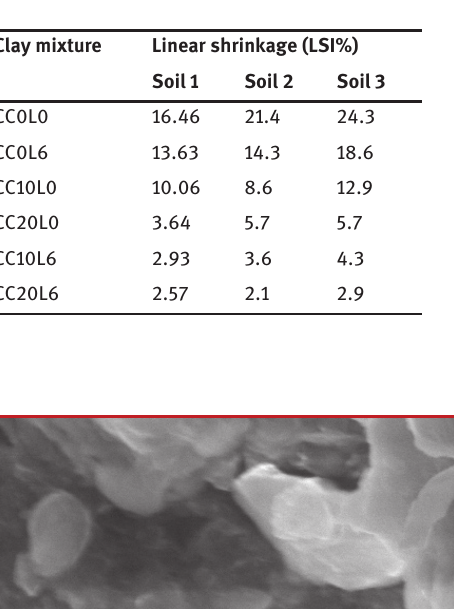
Figure 9. SEM micrograph and EDX analysis of natural soil 2 cured for 7 days.